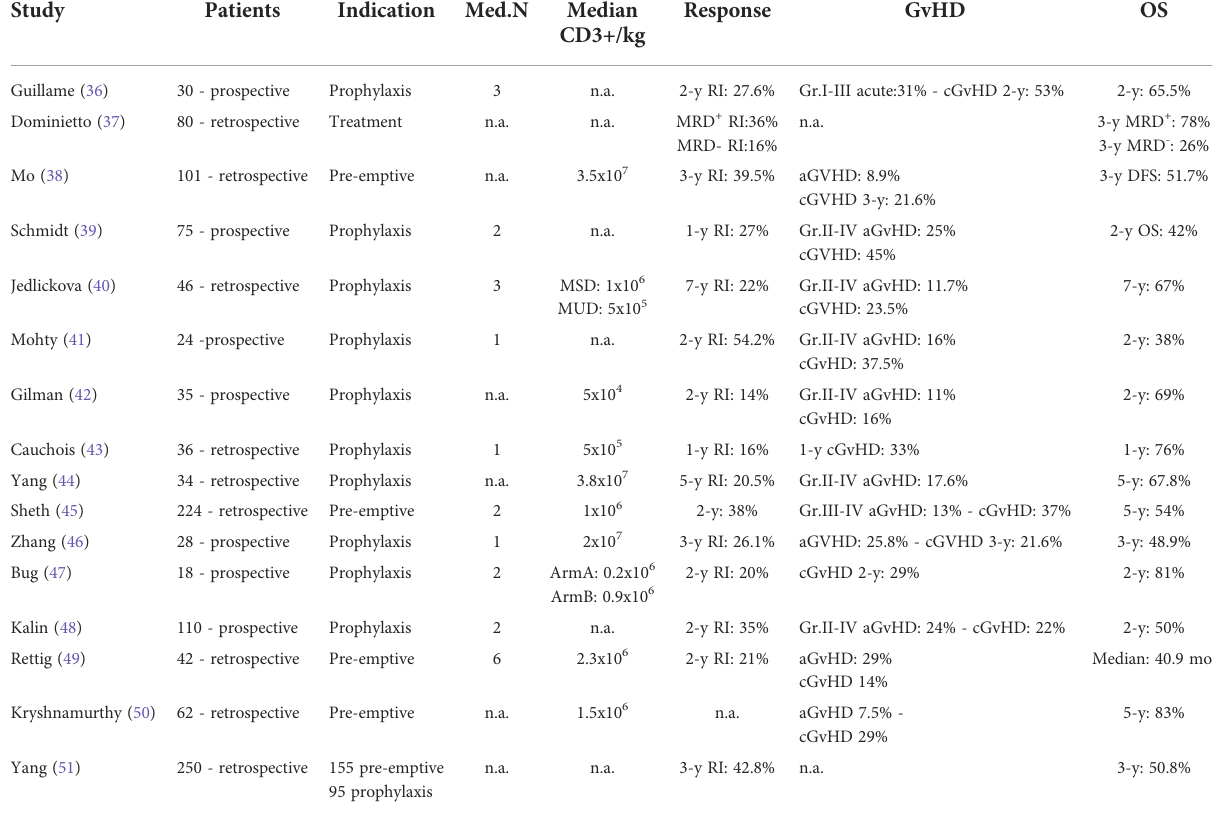
TABLE 2 DLI studies in allogeneic HCT for AML.